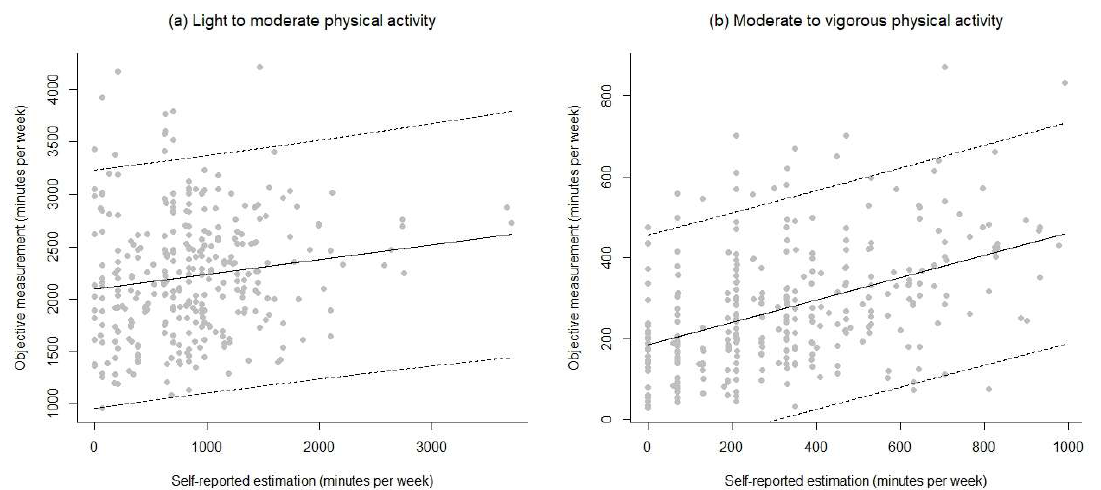
Figure 2. Regression models’ residuals for LMPA and MVPA (self-reported and objective) for the first trimester of pregnancy.